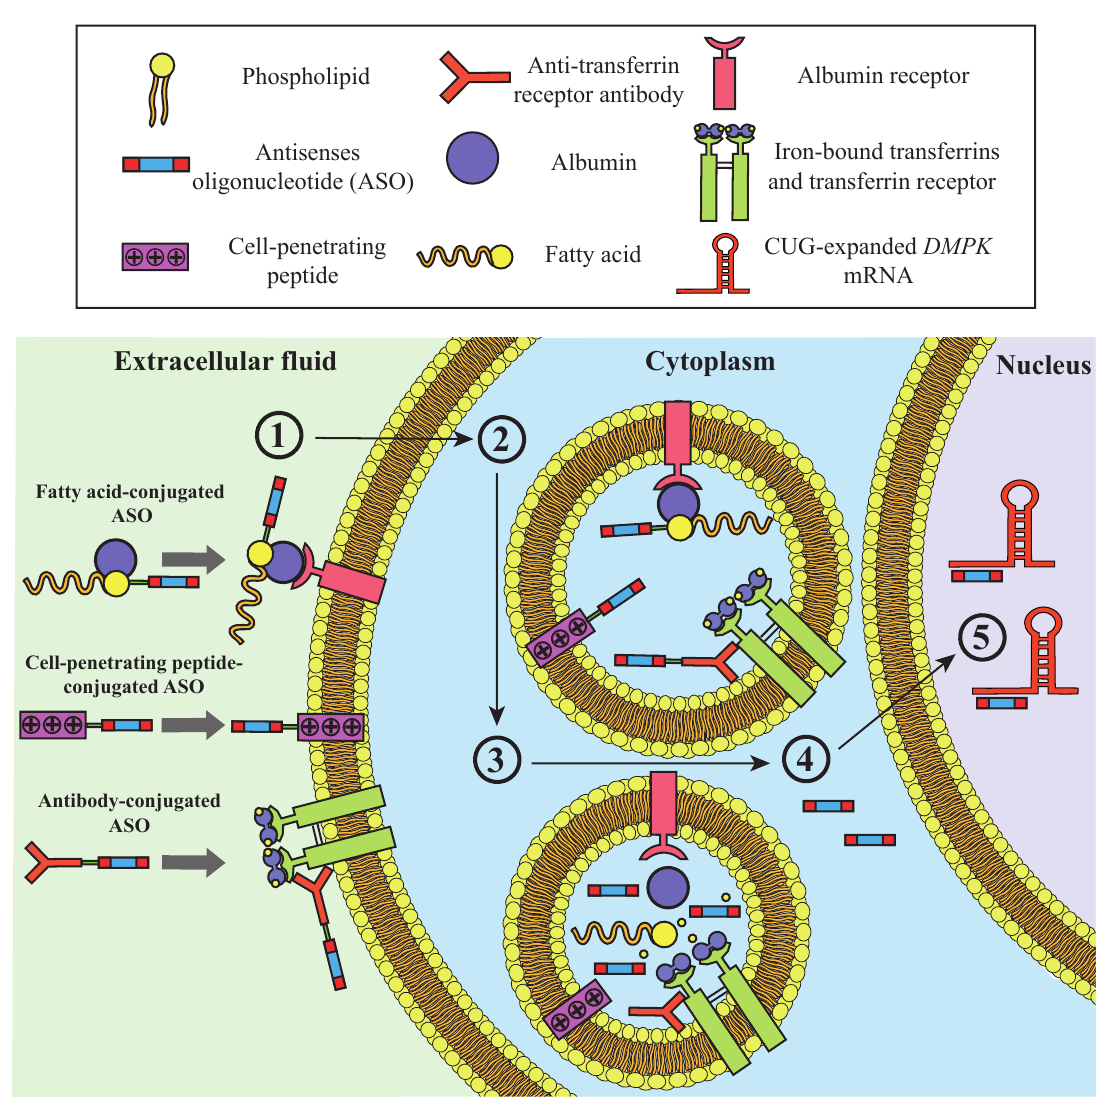
Figure 2. Strategies to enhance antisense oligonucleotide (ASO) intracellular delivery. ASOs may be conjugated to a fatty acid chain, enhancing its affinity to albumin and other serum proteins, to a cell-penetrating peptide (CCP), or to an anti-transferrin receptor 1 (TfR1) monoclonal antibody to promote cell uptake. (1) Conjugated ASOs are localized at the cell membrane, either because of the conjugate binding to specific cell receptors or because of interactions of the CCP with the cell membrane. (2) ASOs are then internalized in early endosomes by endocytosis. (3) An increase in pH in endosomes promotes cleavage of the ASOs’ linker and their release from the conjugates. (4) A small portion of ASOs escape the endocytic vesicles and cross the nuclear pores to the nucleus, (5) where they can target CUG-expanded